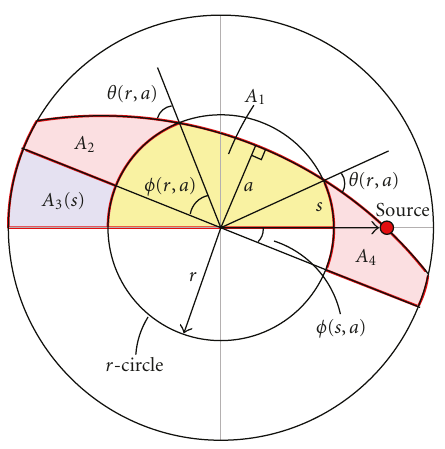
Figure 8: Calculating the total tra ffi c flow from a source point at distance s from the origin crossing the r